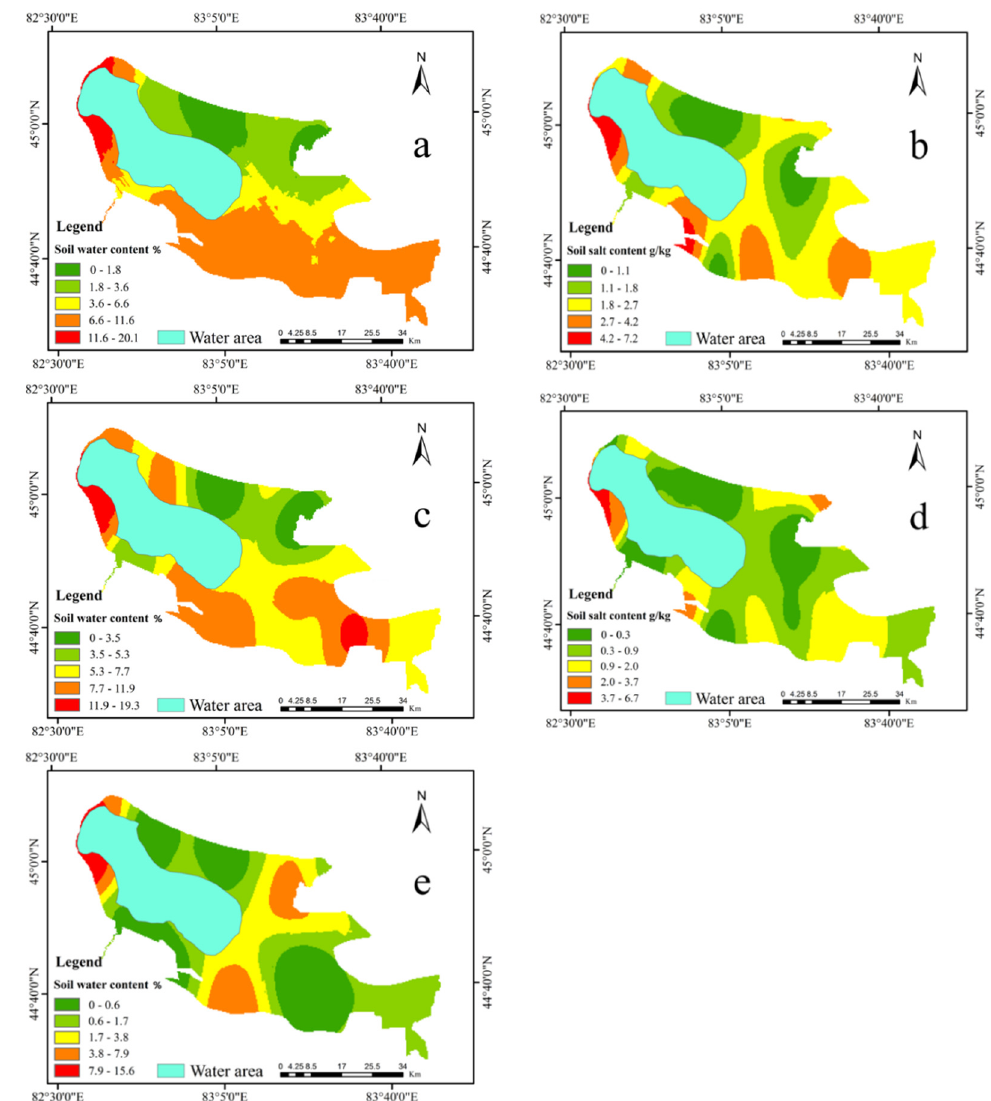
Figure 5. Data of salinization risk factors obtained by GIS interpolation in dry season: ( a ) spatial distribution of the SH_wat risk factors; ( b ) spatial distribution of the SH_sal risk factors; ( c ) spatial distribution of the D_wat risk factors; ( d ) spatial distribution of the D_sal risk factors; and ( e ) spatial distribution of the S_wat risk factors.